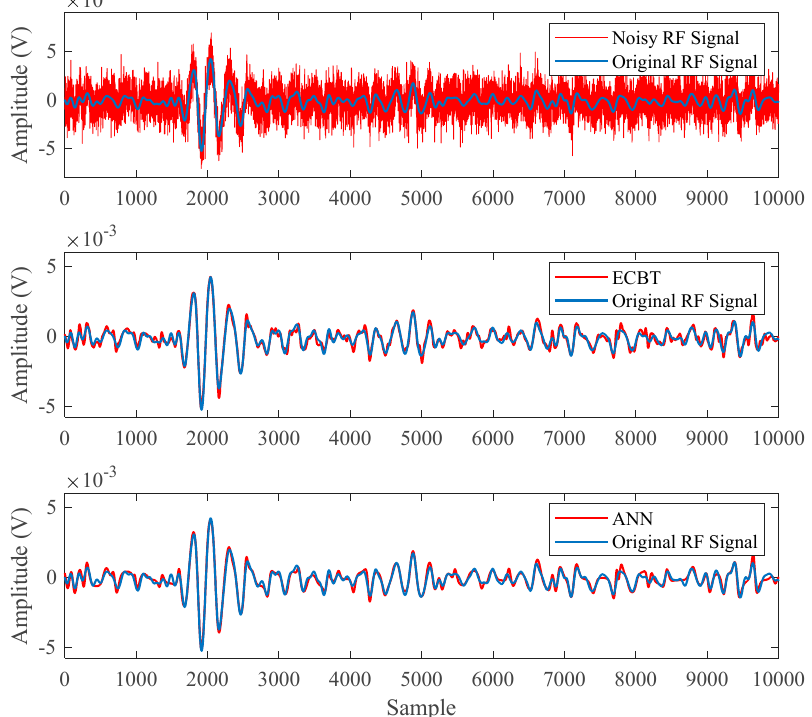
Figure 8. Denoising of RF signal, ‘crack’ type, in the case of PSNR = 1.